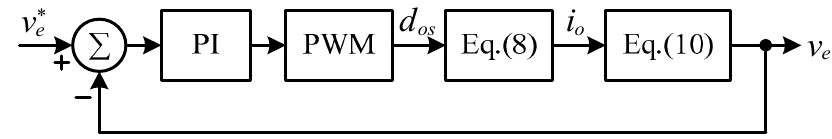
Figure 6. The block diagram for the neutral point voltage control loop.